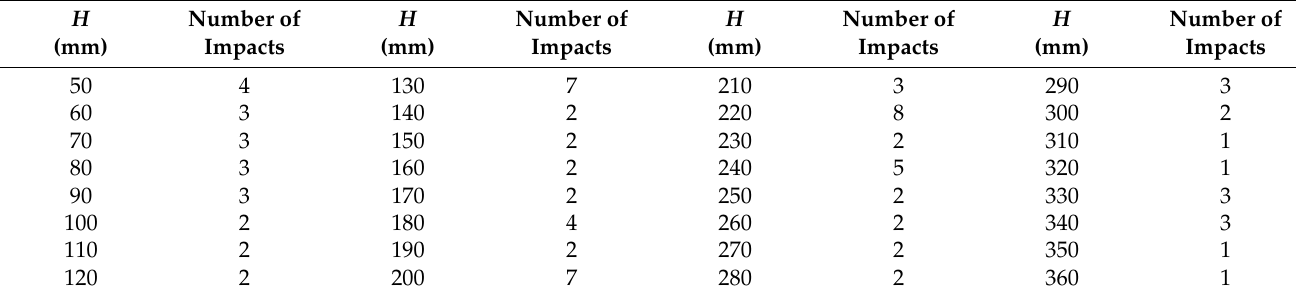
Table 3. Release height ( H ) and repeated impact